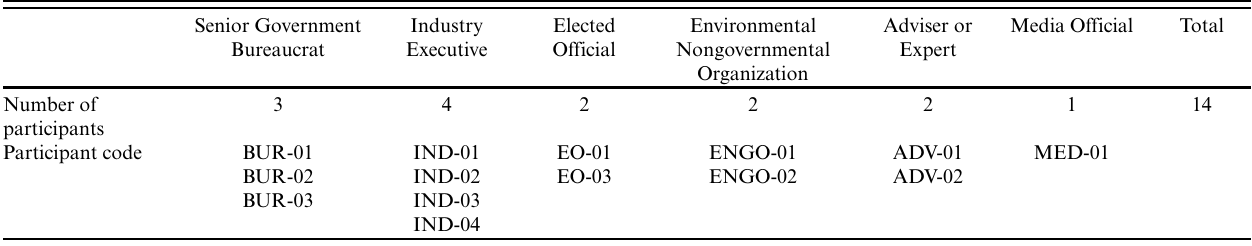
Table 1 . Summary of case study participants and their respective roles.